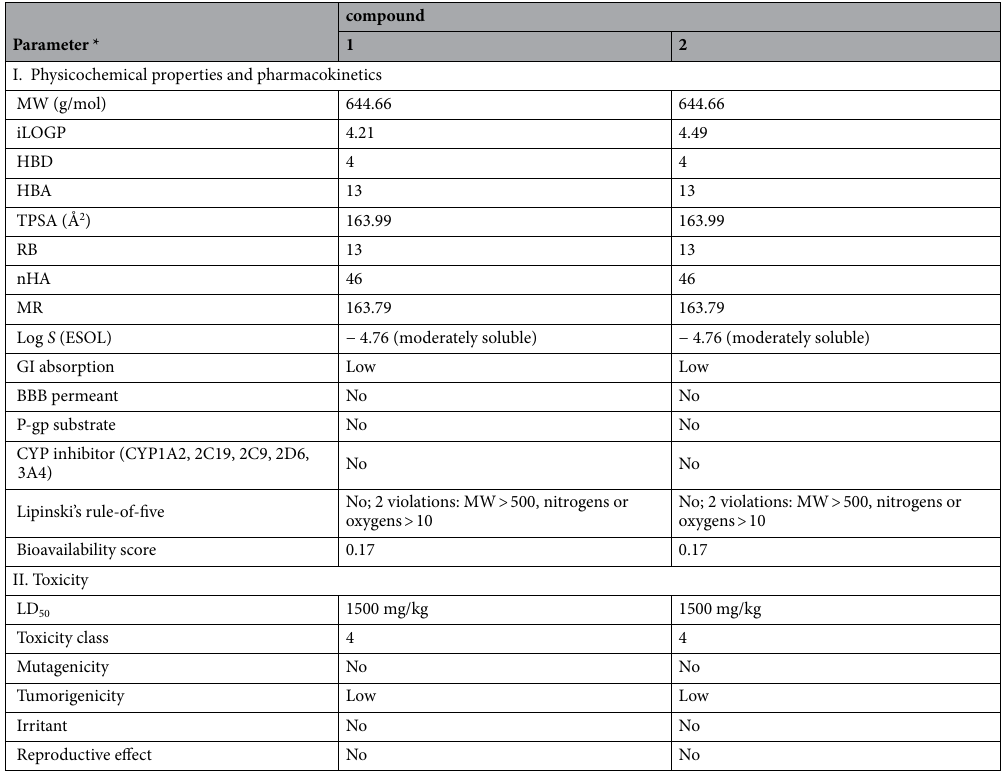
Table 3. Calculated ADMET parameters of 1 and 2 . *The acronyms were referred to their full terms as follows: MW molecular weight, iLOGP octanol/water partition coefficient, HBD number of H-bond donors, HBA number of H-bond acceptors, TPSA topological polar surface area, RB rotatable bonds, nHA number of heavy atoms, MR molar refractivity, Log S (ESOL) decimal logarithm of the molar solubility in water (ESOL model), GI absorption gastrointestinal absorption, BBB permeant blood–brain barrier permeant, P-gp substrate permeability glycoprotein substrate, CYP inhibitor cytochrome P450 inhibitor, LD 50 median lethal dose. Lipinski (rule-of-five) and Abbot bioavailability score are the assessment for the oral